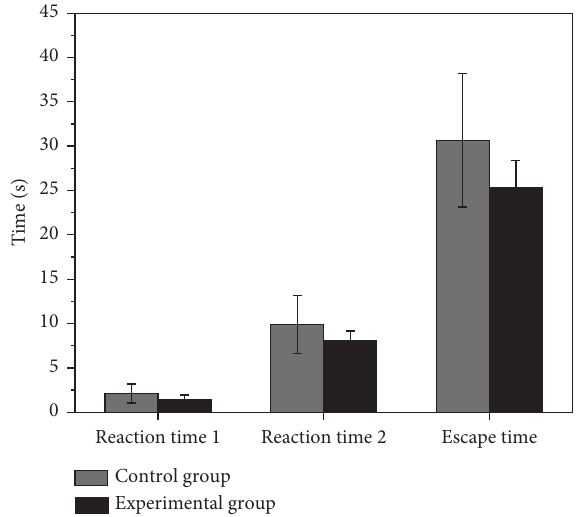
Figure 12: Average time for the control and experimental groups after the VR evacuation experiment. The error bars represent the standard error of the difference between the two